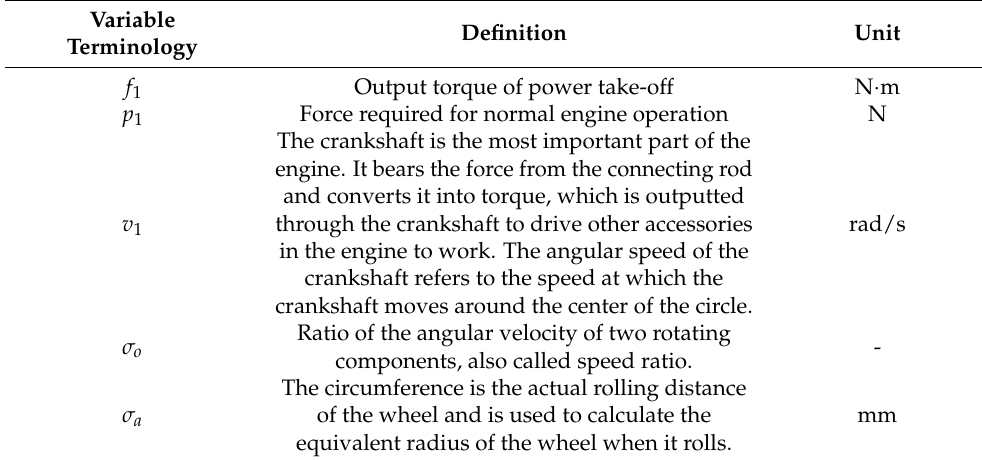
Table 1. Terms of model